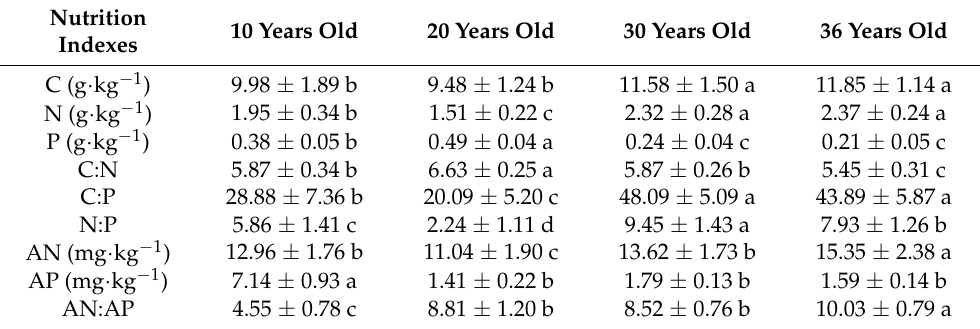
Table 2. Soil main element concentrations and their stoichiometric ratios along a chronosequence of P. massoniana